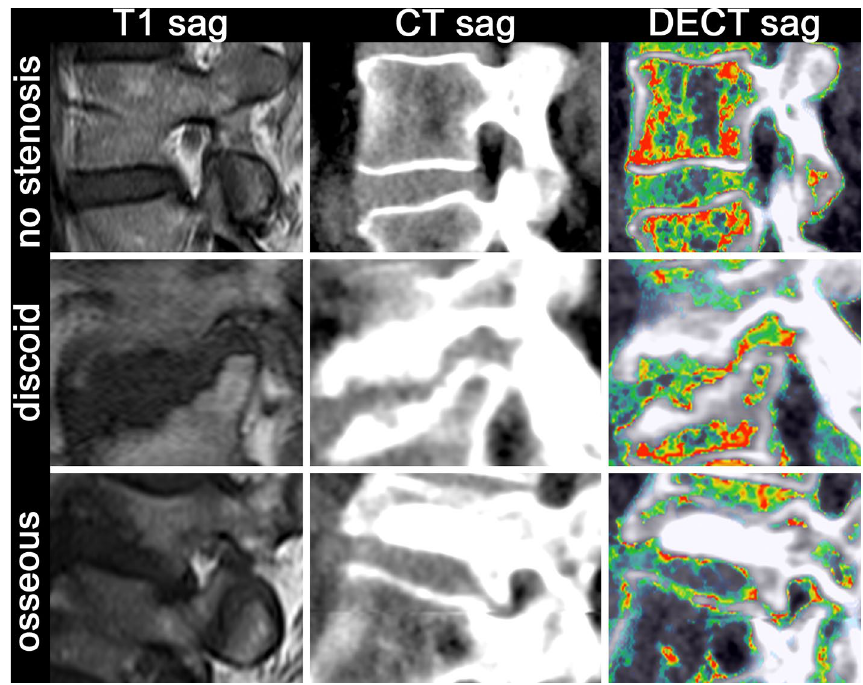
Figure 1. Imaging examples of no foraminal stenosis as well as discoid and osseous stenosis in (left to right) MRI, standard CT, and collagen-sensitive dual-energy